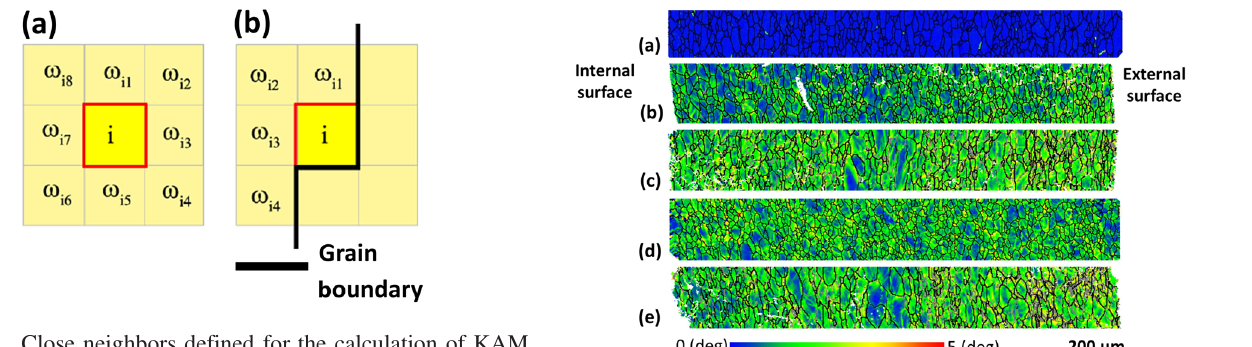
FIG. 14. Close neighbors defined for the calculation of KAM ( 3 × 3 ) in a pixel inside a grain (a) and close to a grain boundary (b) [31]. FIG. 15. KAM ( 3 × 3 ) maps for nonformed specimen (a) and for formed specimens extracted from SRF half-cells formed by electrohydraulic forming and by spinning: (b) EHF equator; (c) spinning equator; (d) EHF iris; (e) spinning iris. The external surface of the half-cell is on the right of the image, while the internal surface of the half-cell is on the left of the image. White zones inside the KAM maps represent nonindexed